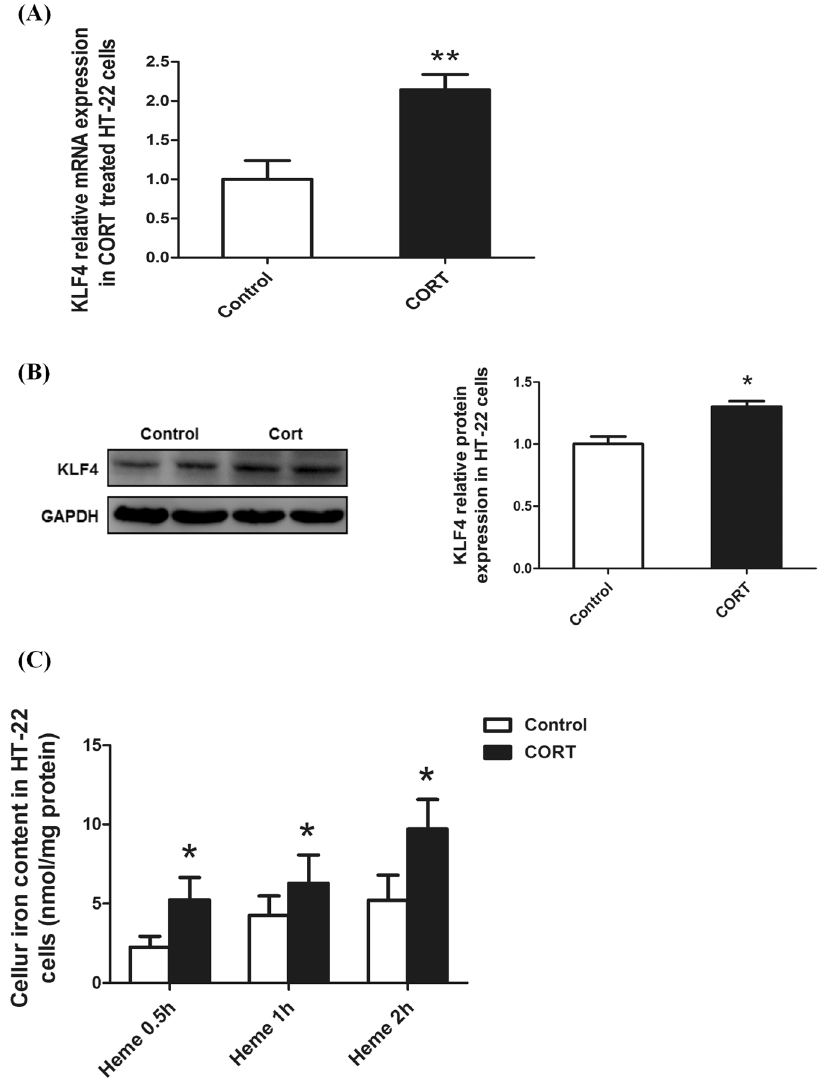
Figure 4. KLF4 expression and hemin uptake are increased in hippocampus and cortex of the PS rat brain and CORT-treated HT-22 cells. ( A , B ) KLF4 mRNA and protein expressions were elevated in HT-22 cells treated with 30 μ M CORT for 24 h. ( C ) The cellular iron content was increased markedly in cells pre-treated with corticosterone than only treated with hemin. Values are means ± SD. * p < 0.05; ** p <